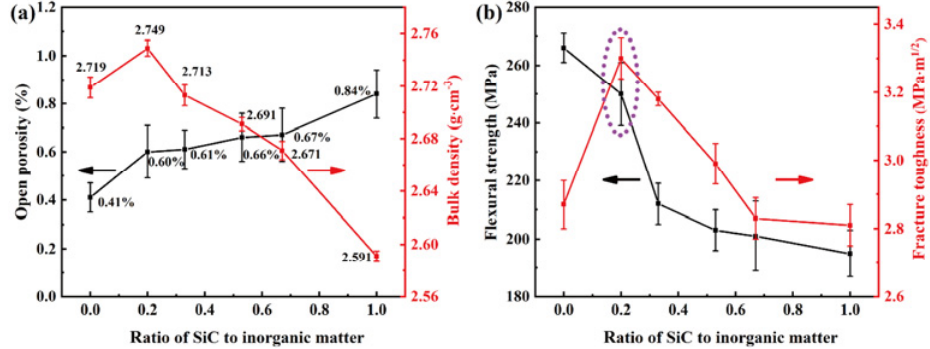
Fig. 12 RT mechanical properties of SiC composites: (a) O and ρ and (b) flexural strength and K IC